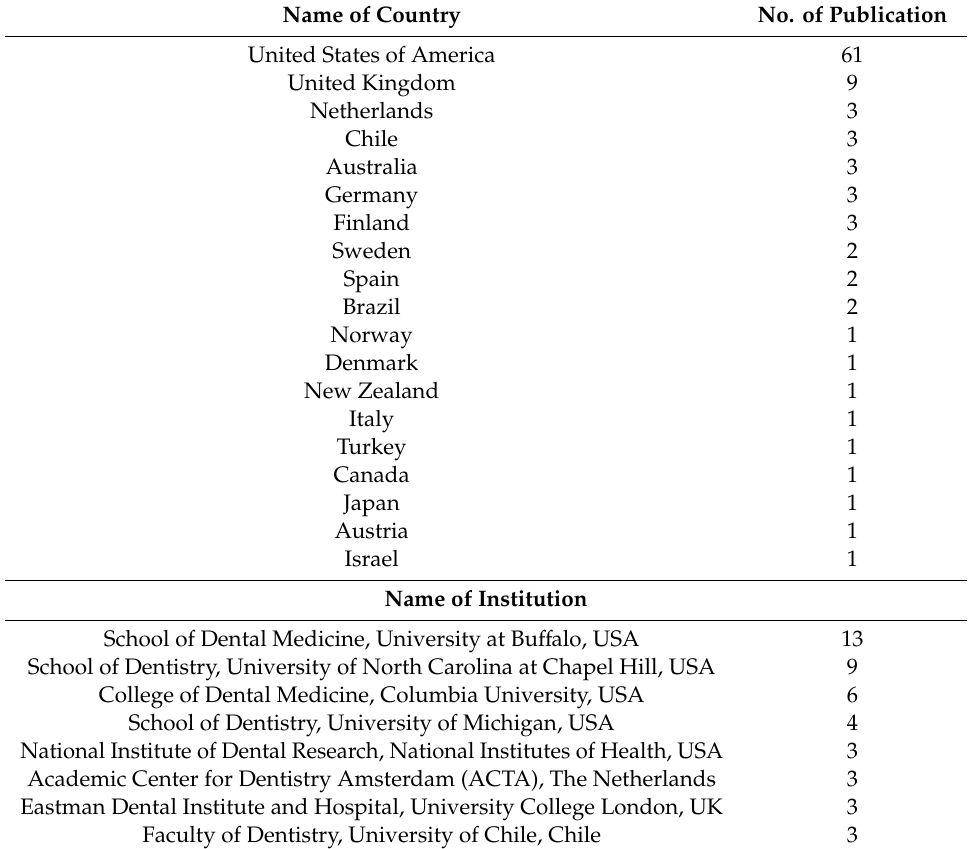
Table 1. List of contributing countries and institutions to the most-cited publications. Name of